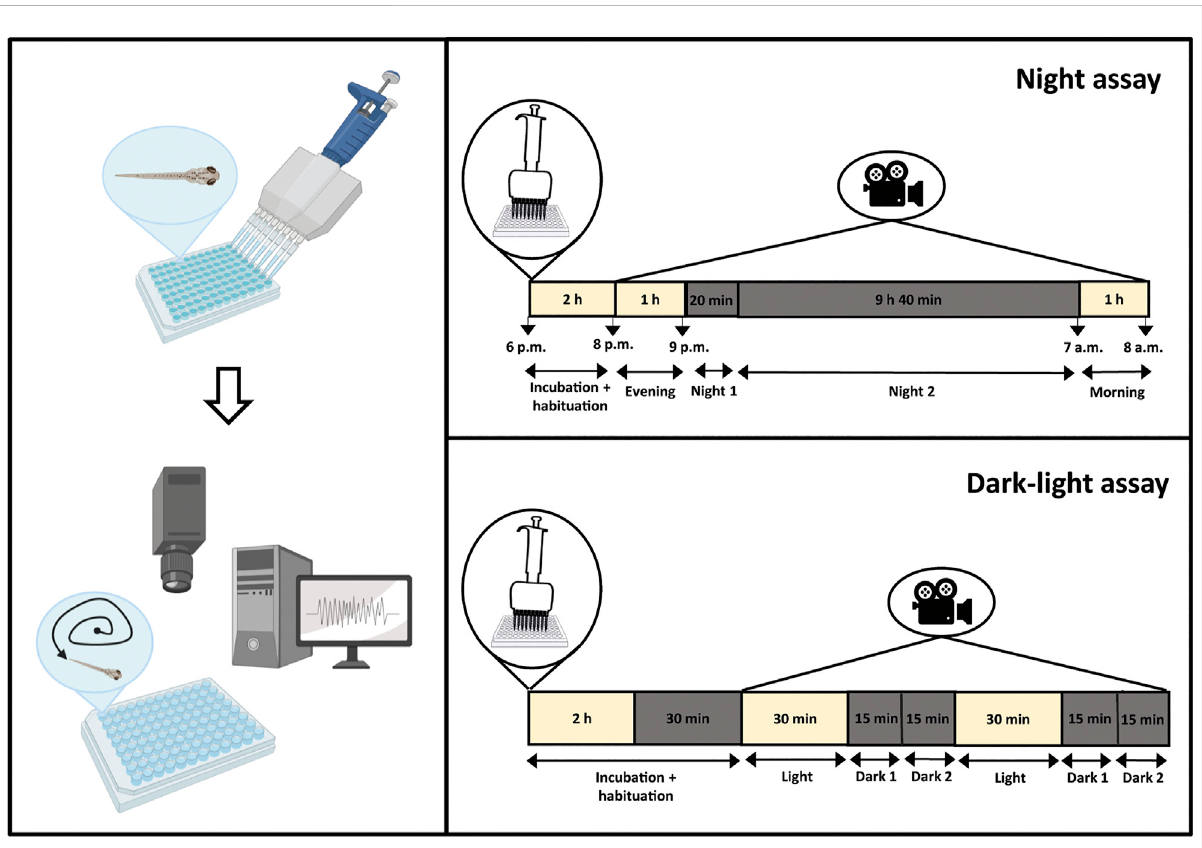
FIGURE 1 Behavioralanalysisofzebra fi shlarvae.Zebra fi shlarvaewereplacedseparatelyina96-wellplateandincubatedwithcompoundorvehicle(VHC, 1% DMSO in embryo medium). After incubation, the 96-well plate was placed in an automated tracking device and larval behavior was recorded for varyingtimesbytheZebralabsoftware.Thenightassayconsistedofa2 hincubationandhabituationperiod,followedbya12 hrecordingperiodwith a1 hlightphasefrom8p.mto9p.m.,a10 hdarkphasefrom9p.mto7a.m.,andagaina1 hlightphasefrom7a.mto8a.m.Thedark-lightassay consistedofa2 h30 minincubationandhabituationperiod,followedbya2 hrecordingperiodwithalternating30 mindark-lighttriggersduringthe day. Figure created with